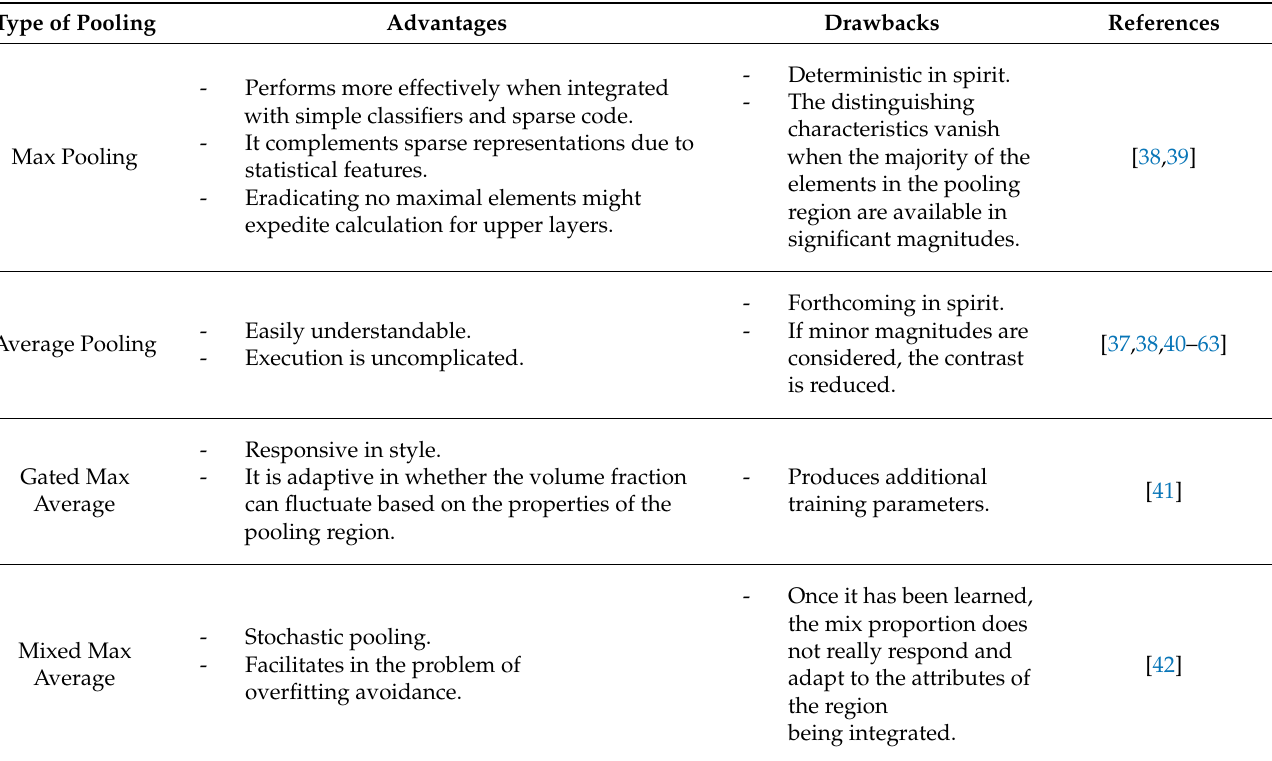
Table 1. Advantages and disadvantages of different pooling approach in